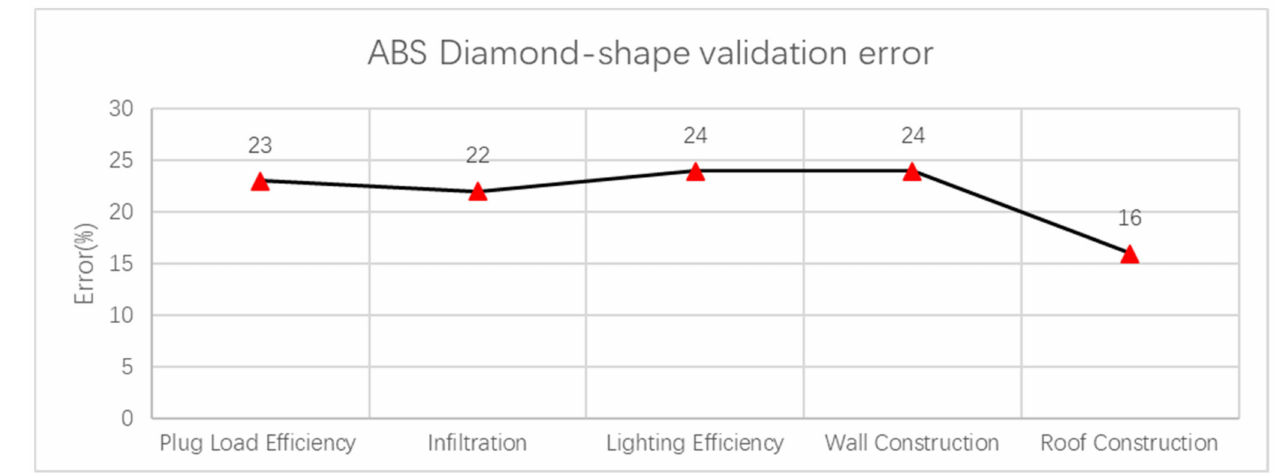
Figure 19. Case study ABS diamond shape error.